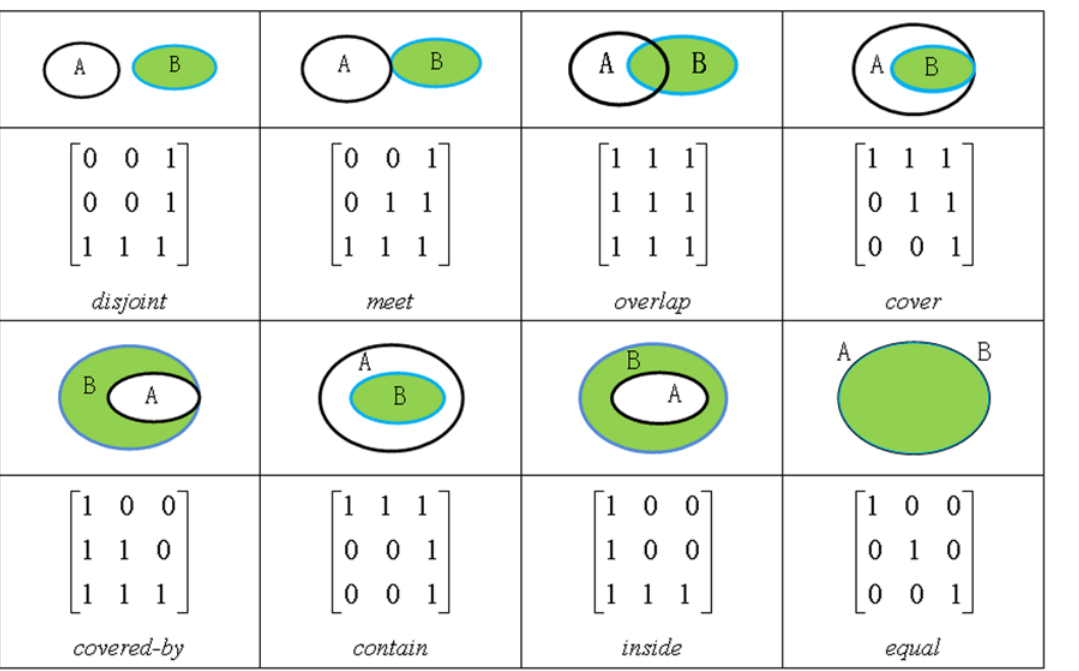
Fig 2. The eight basic topological relations between two simple crisp regions [36]